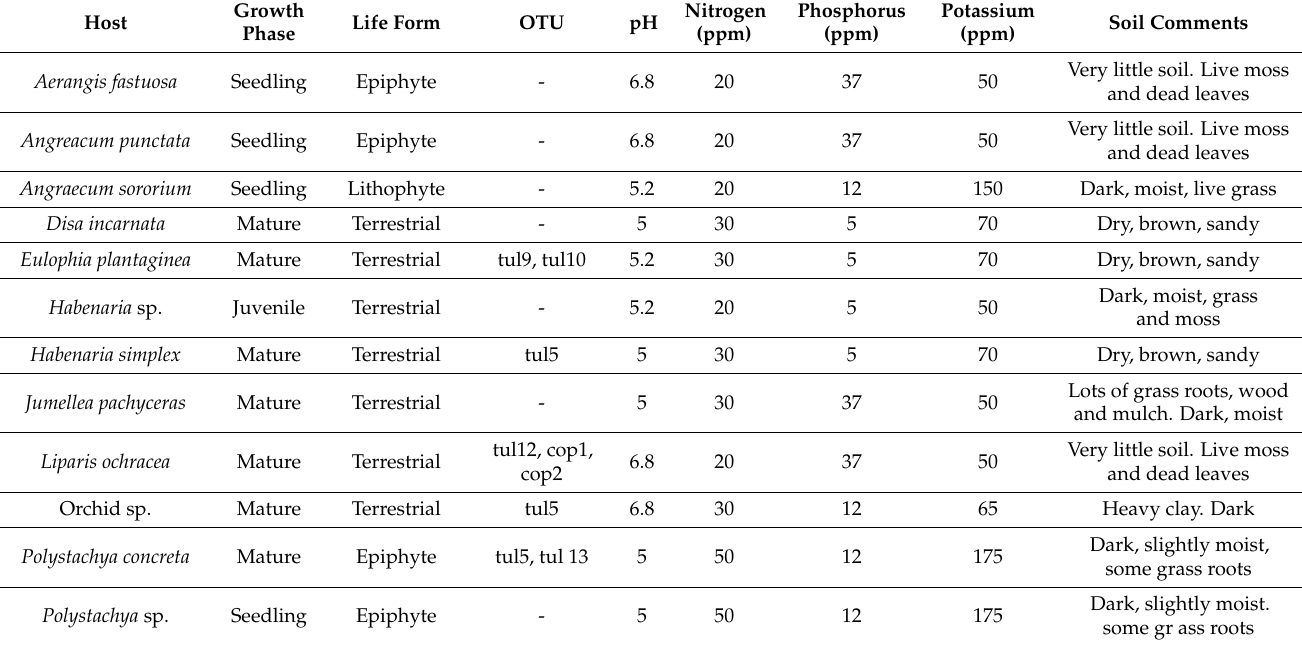
Table 2. Soil data collected during the rainy season from 12 orchids representing three life forms (Figure 2).